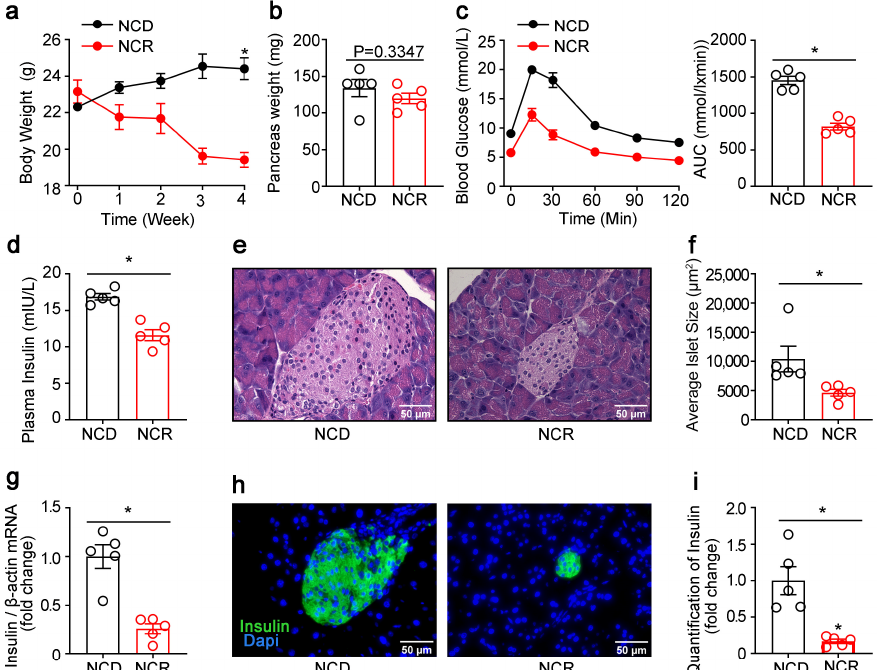
Figure 1. CR reduced β -cell area and insulin production in regular diet-fed mice. ( a ) Body weight curves of calorie-restricted NCD-fed mice. ( b ) Weight of the pancreas. ( c ) Intraperitoneal glucose tolerance test. ( d ) Insulin levels were measured at 15 min after glucose injection. ( e ) HE staining of pancreatic sections. ( f ) Quantification of islet size. ( g ) Insulin mRNA. ( h ) Immunofluorescence staining for insulin (insulin, green) in the pancreases of NCD or a diet restricted to 70% of the calories of the ad libitum group (NCR). Nuclei were stained with DAPI (blue). ( i ) Quantification of insulin. The results were expressed as mean values ± SEM. (Five mice per group) * p < 0.05 vs. NCD mice. We further examined whether CR led to apoptosis in β‐ cells. We performed double immunofluorescence staining of insulin and cleaved caspase ‐ 3 (CC3), as well as insulin and death receptor Fas/CD95 on mouse pancreas tissues. As shown in Figure 2, immuno ‐ fluorescence signals of CC3 (Figure 2a,b) and Fas/CD95 (Figure 2c,d) were increased in NCR mice islets, which co ‐ localized with the insulin signals, suggesting increased β‐ cell apoptosis after CR.